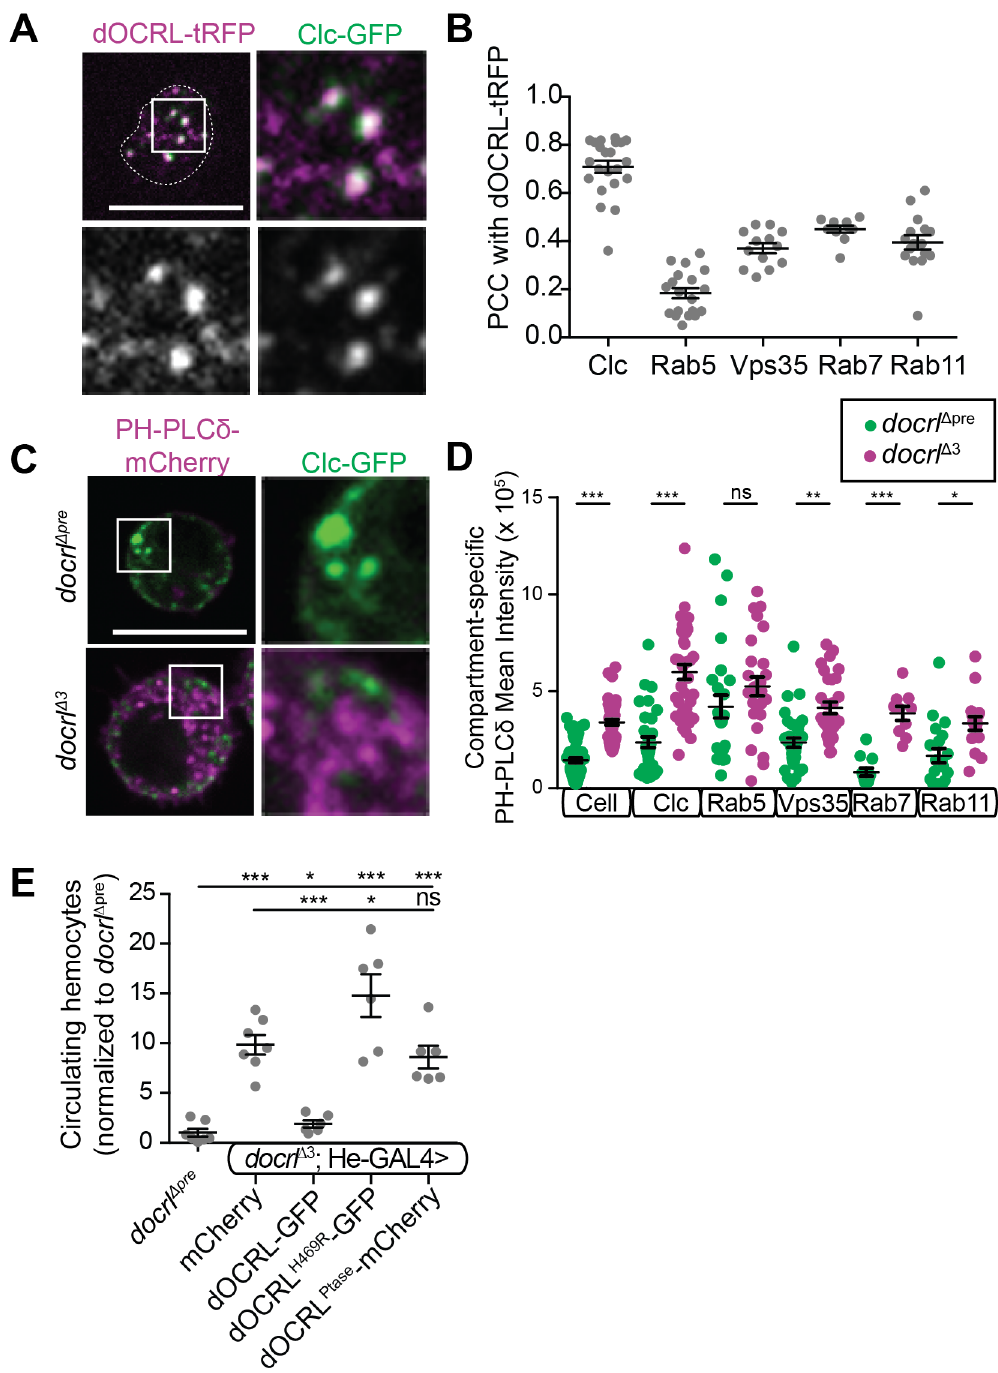
Fig 3. OCRL regulates PIP 2 homeostasis in diverse endosomal compartments. (A) Endogenously tagged dOCRL (magenta) co-localizes strongly with Clc-GFP (green), singlechannelconfocalslices shown belowin gray. (B) Pearson correlationsbetweenendogenously taggeddOCRL and trafficking compartmentsin live primary hemocytes. dOCRL localizesonly moderately with other endosomalcompartments. (C-D) docrl Δ 3 hemocytes exhibit increasedPH-PLC-Cherry marker of PIP 2 (magenta) in live primary hemocytes in all membranecompartments examined(green). (E) The phosphatase activity of dOCRL is necessary but not sufficient to restrict hemocyte number. Scale bars in A,C are 10 μ m. Data are presentedas mean +/- SEM. Individual values in B,D represent single cells. Associated with S4 Fig.